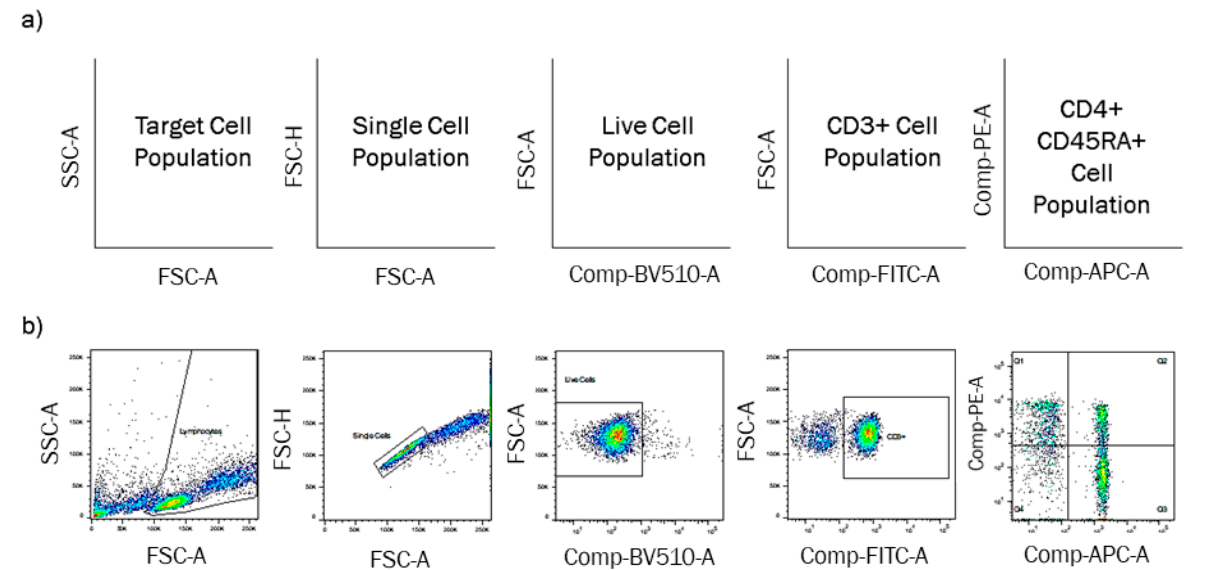
Figure 1. ( a ) Gating sequence participants were asked to follow, to identify the target single live cell population, with CD3+ CD4+ CD45RA+ for naïve T-cells. ( b ) Second gating sequence participants followed (Phase 2), identical to ( a ) but with additional diagrammatical information of the plots and gates, which participants had to copy.